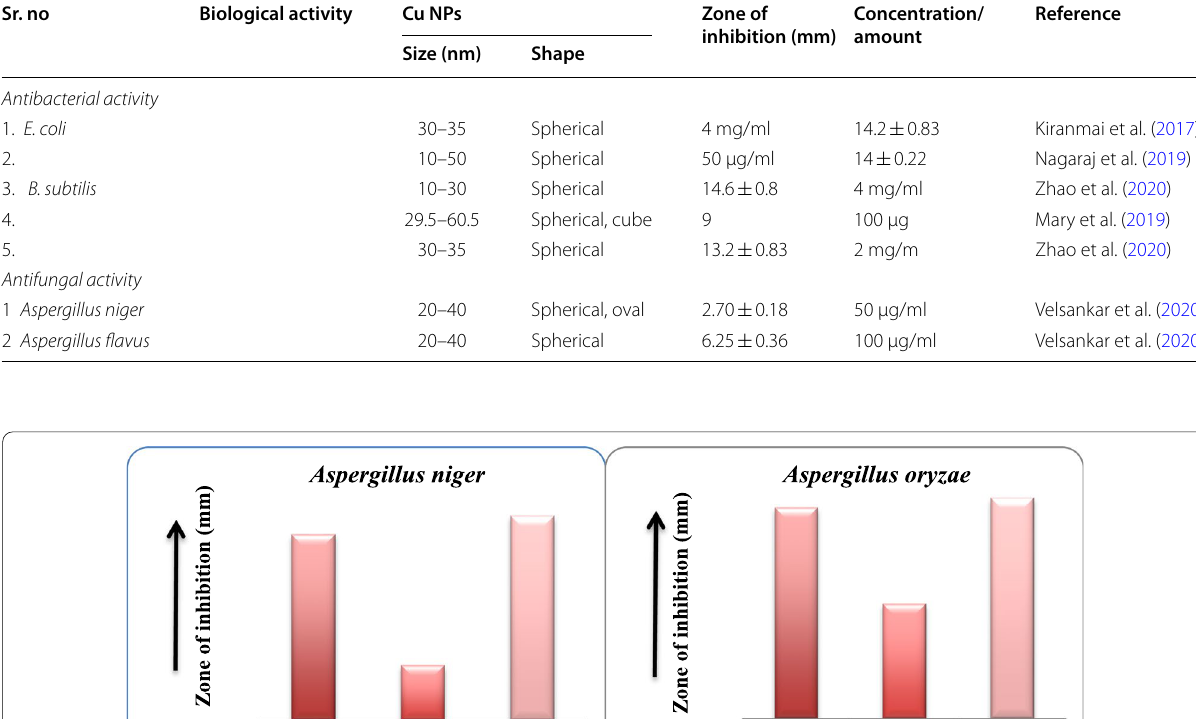
The CuNPs were tested against hatchlings of A. aegypti